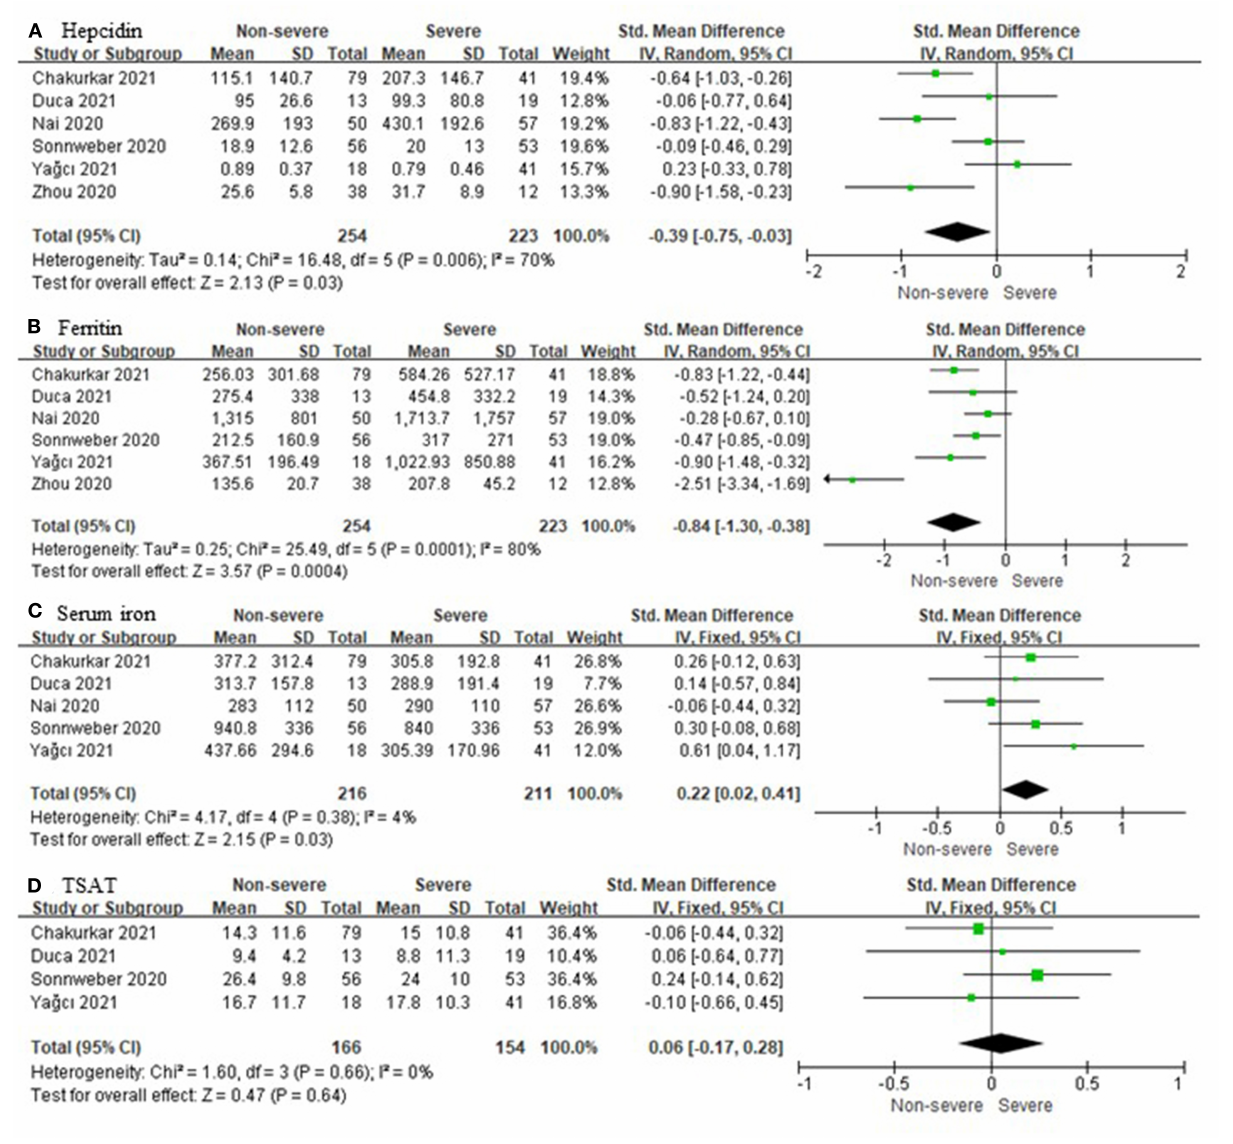
SARS-CoV-2. Hepcidin-mimetic action of SARS-CoV-2